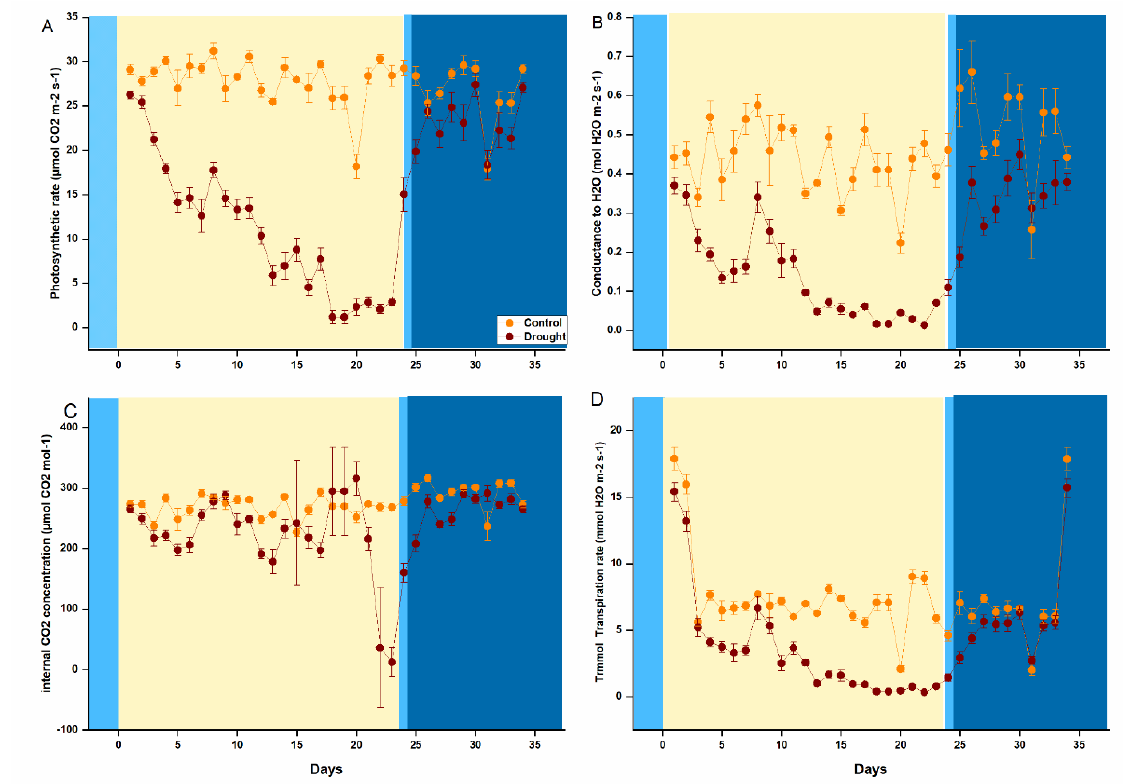
Figure 1. Measurements of Photosynthetic actives of Pinus tabuliformis seedlings ( A ) Photosynthetic rate (A N ), ( B ) Conductance to H 2 O (g s ). ( C ) Internal CO 2 concentration (C i ), and ( D ) Transpiration rate (E). All the mentioned parameters were measured by using a portable photosynthesis system (LI-6400T, Li-Cor Inc., Lincoln, NE, USA). Different colors represent irrigation and drought conditions (Blue: Watring, light orange: Drought and Dark Blue: Recovery).